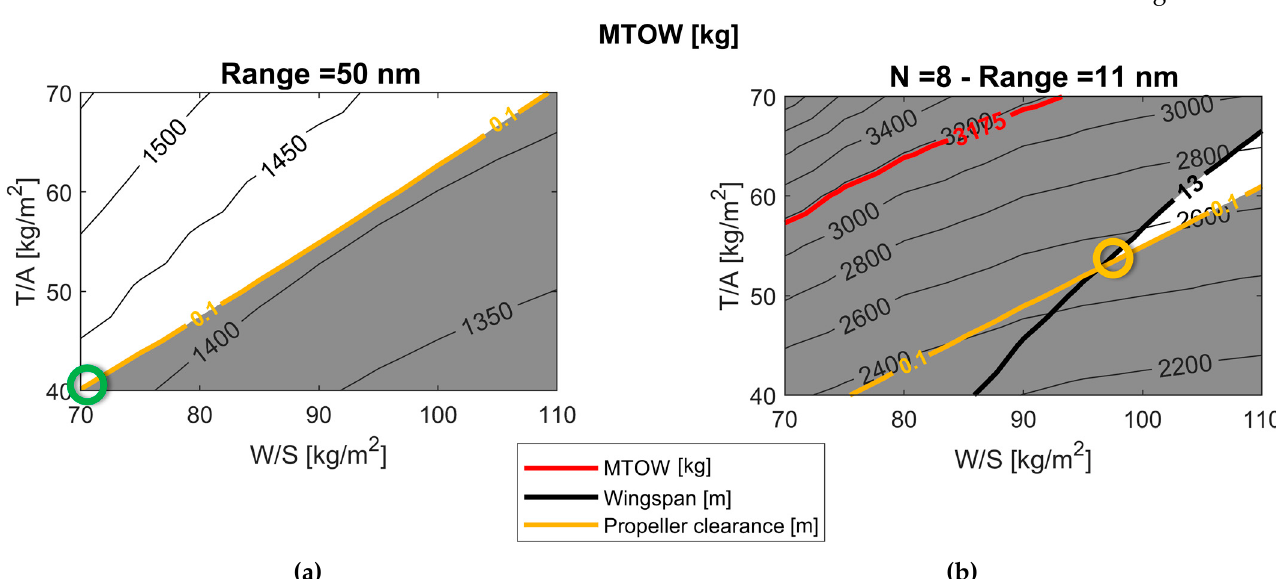
Figure 19. Selection of the configuration for different design missions: ( a ) single mission; ( b ) multi mission. For both, the cruise speed is equal to 45 m/s.